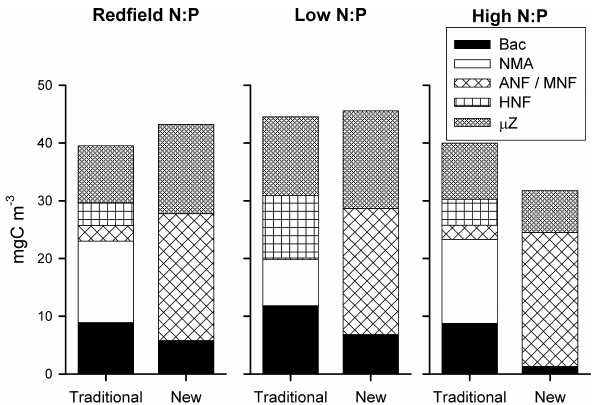
Fig. 4. Model output at steady state, showing the standing stock contributions to biomass of bacteria (Bac), non-motile microalgae (NMA), heterotrophic nanoflagellates (HNF), and the microzoo- plankton (µZ). In the traditional paradigm, the flagellates capable of phototrophy (as ANFs) have no mixotrophic potential, while in the new paradigm they (as MNFs) exhibit mixotrophy (see also Figs. 2 and 3). The inorganic nutrient regimes (all with 1µM inorganic N) are in Redfield N:P (molar ratio 16), low N:P (molar ratio 4), or high N:P (molar ratio